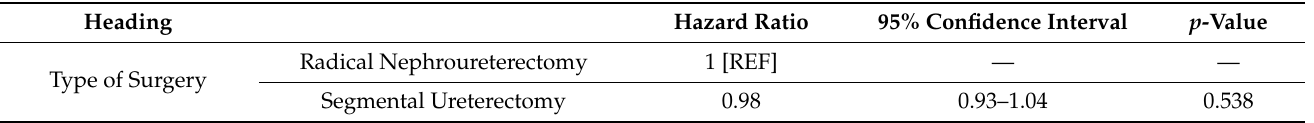
Figure 2. Overlap weighting-adjusted Kaplan–Meier analysis of overall survival in patients who received Radical Nephroureterectomy with bladder cuff excision vs. Segmental Ureterectomy for localized ureteral cancer. Number at risk from the non-adjusted population. Table 3. Univariate Cox proportional hazards regression examining the risk of all-cause mortality in patients diagnosed with localized ureteral carcinoma after overlap weighting.